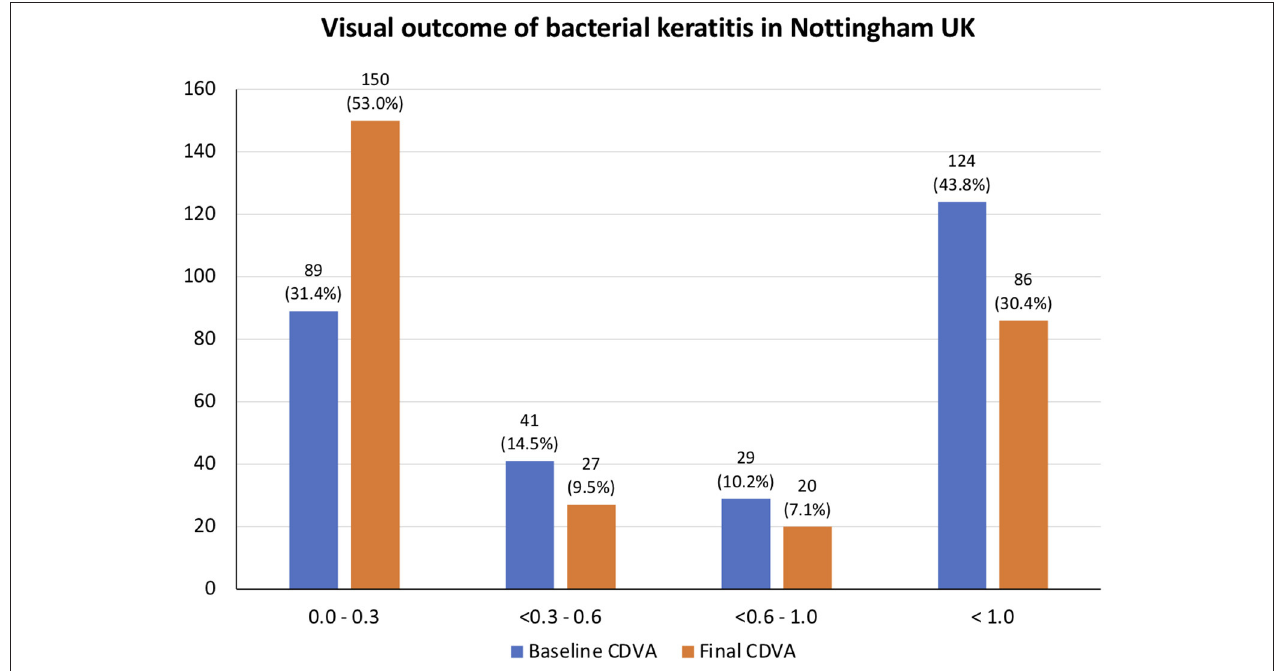
FIGURE 2 | Summary of corrected-distance-visual-acuity (CDVA) of patients with bacterial keratitis at initial presentation and at final follow-up.